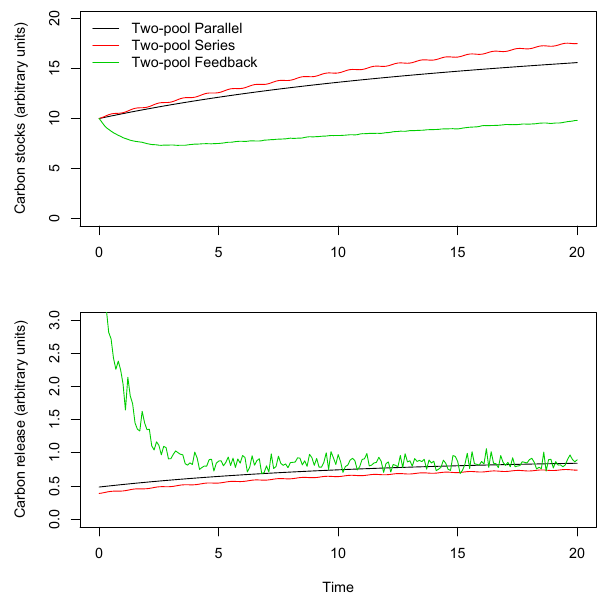
Fig. 3. Examples of three different representations of a two-pool model with different model structures and environmental effects on decomposition rates. The upper panel shows carbon stocks and the lower panel carbon release. Additional details about the implemen- tation are given in the